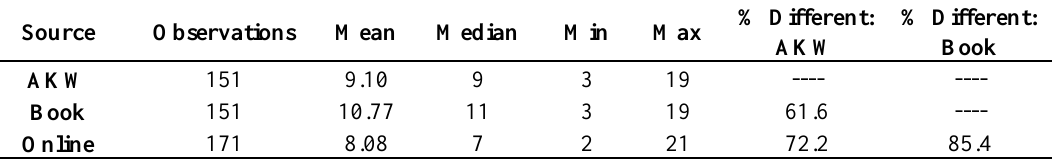
Table 7: Summary statistics for three data sources for the number of required import documents variable Source Observations Mean Median Min Max